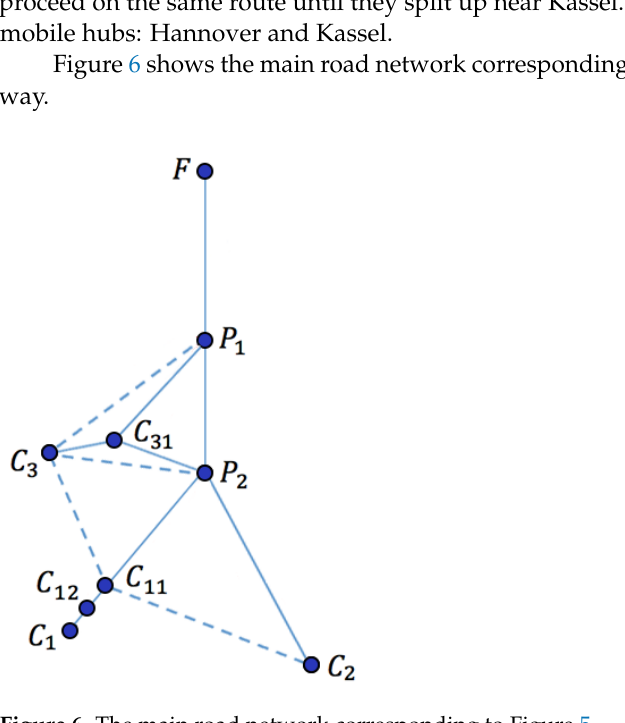
Figure 6. The main road network corresponding to Figure 5. Indicated are the main highways connecting the case locations. In the present situation as well as in the mobile hub case (Section 4.2), we only employ the highways indicated by solid lines in Figure 6. In Section 4.3, where we analyze Case 1 (i.e., all customers are visited by LCVs), we may also employ the ‘dashed’ highways. In particular, the fastest LCV-connection from C 3 to C 1 is to go from C 3 to C 11 , then from C 11 to C 12 and then from C 12 to C 1 .